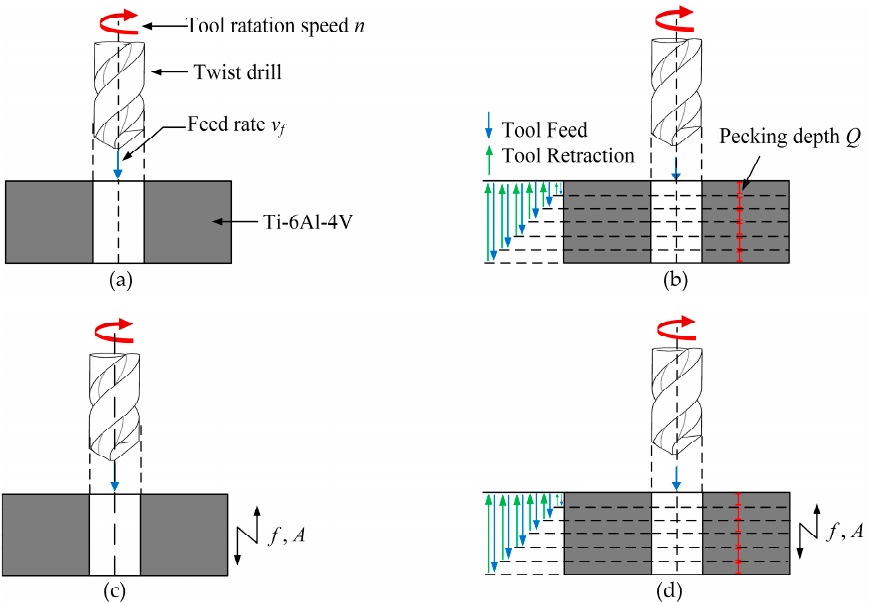
Figure 1. Four drilling techniques used. ( a ) DD; ( b ) PD; ( c ) UVD and ( d ) UVPD.